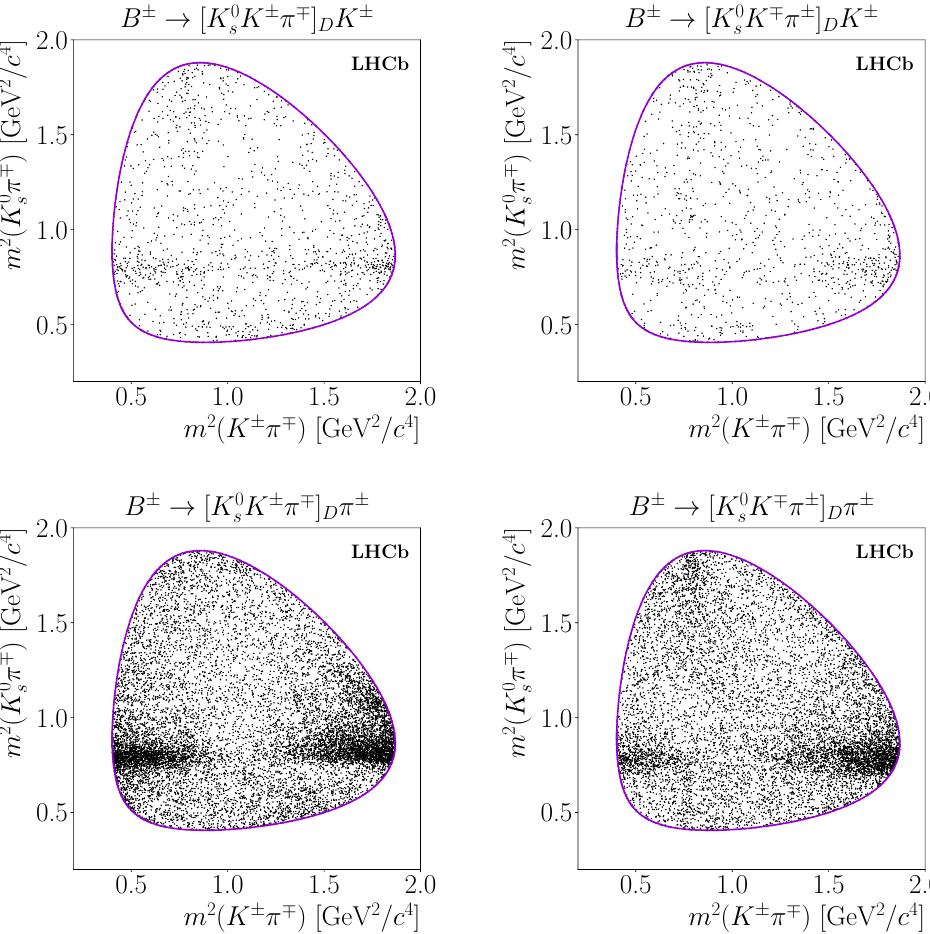
Figure 1 . D K 0 K + (cid:25) (cid:0) Dalitz plots from the SS (left) and OS (right) data samples, for B + S ! DK + (top) and B + D(cid:25) + (bottom). Both long and downstream K 0 ! purple lines indicate the kinematic